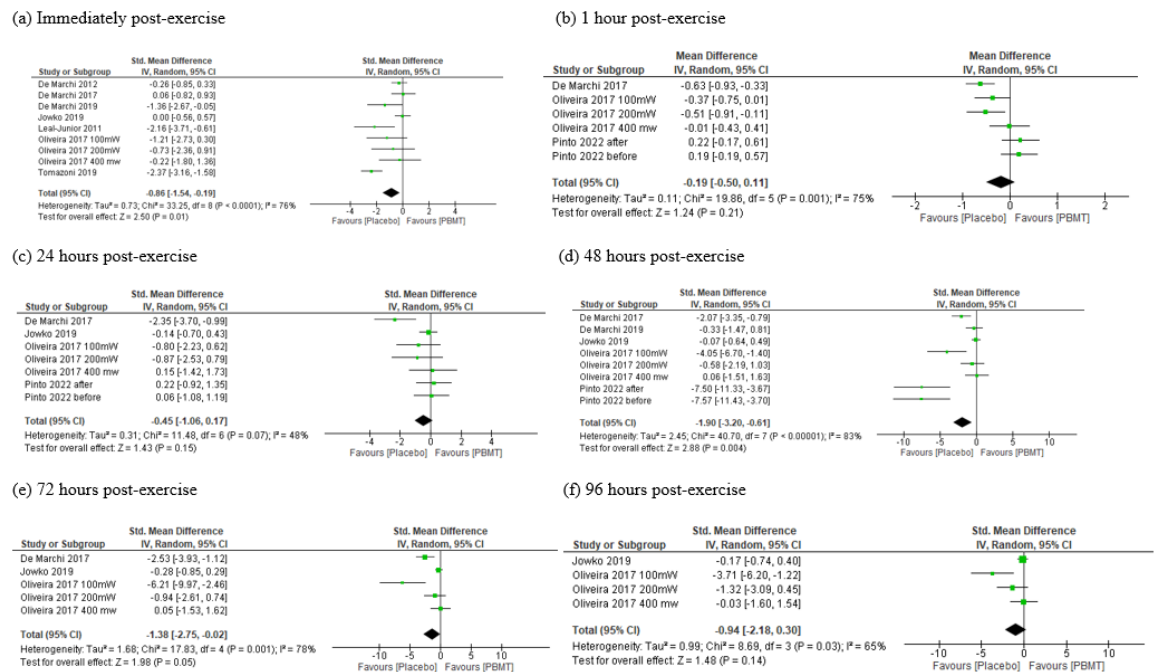
Figure 4. Meta-analysis damage to lipids immediately post exercise ( a ) and 1 h ( b ), 24 h ( c ), 48 h ( d ), 72 h ( e ) and 96 h ( f ) post exercise. PBMT — photobiomodulation, IV — inverse variance, CI — ( e ) and 96 h ( f ) post exercise. PBMT—photobiomodulation, IV—inverse variance, CI—confidence interval. confidence interval.